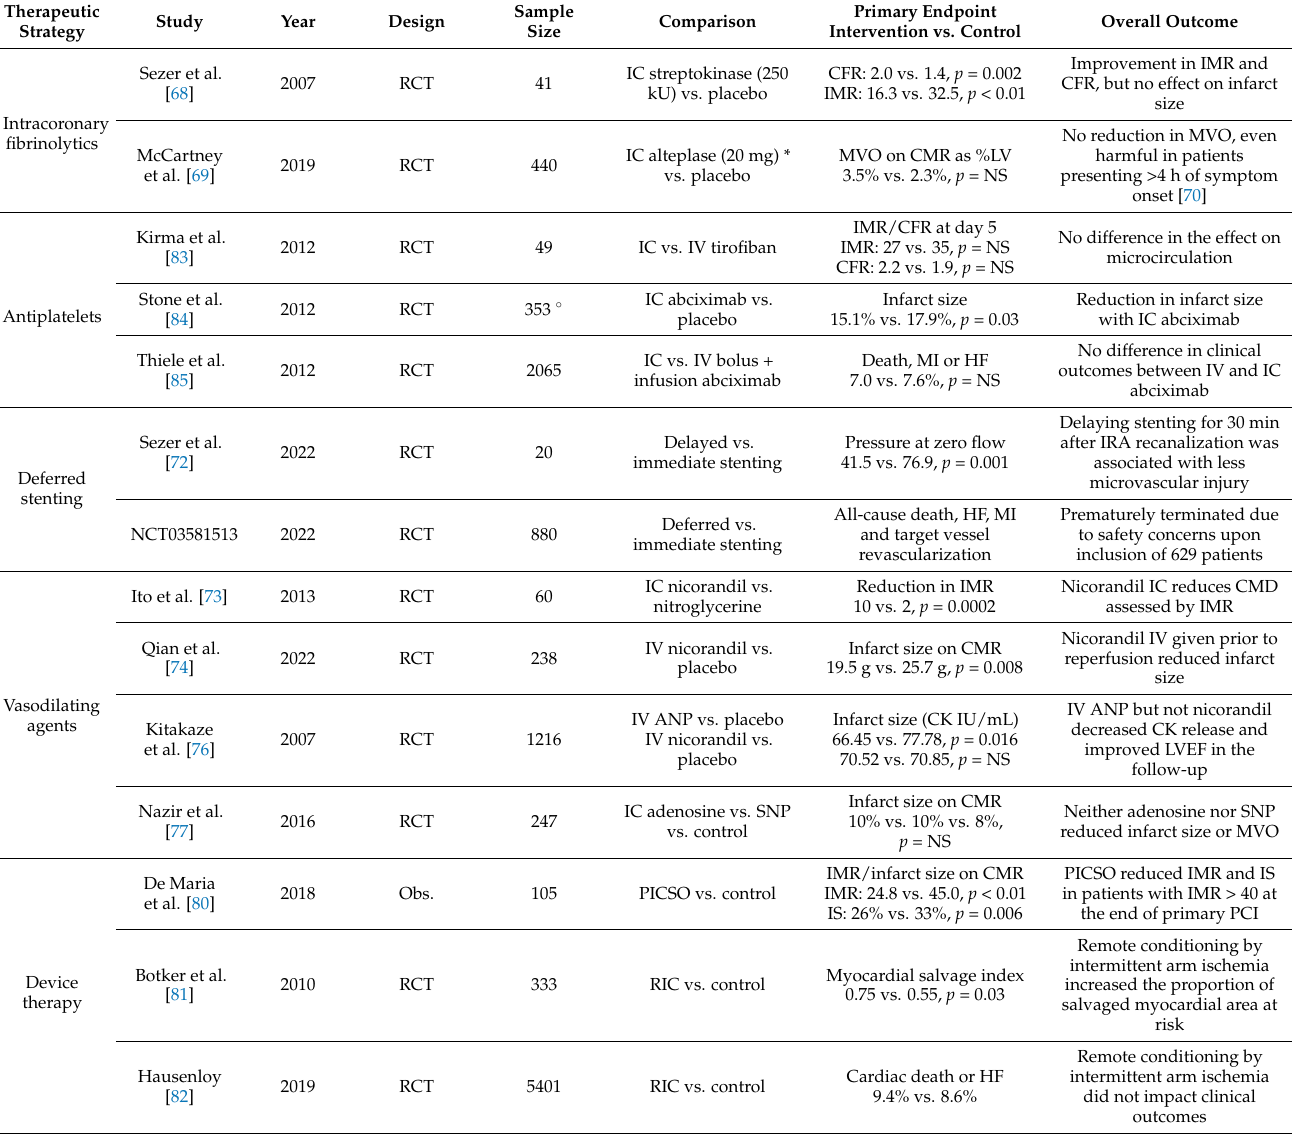
Table 2. Overview of different therapeutic strategies targeting coronary microvascular dysfunction after STEMI with representative trials depicting translation from microcirculation- and infarct size- to-clinical outcomes-based